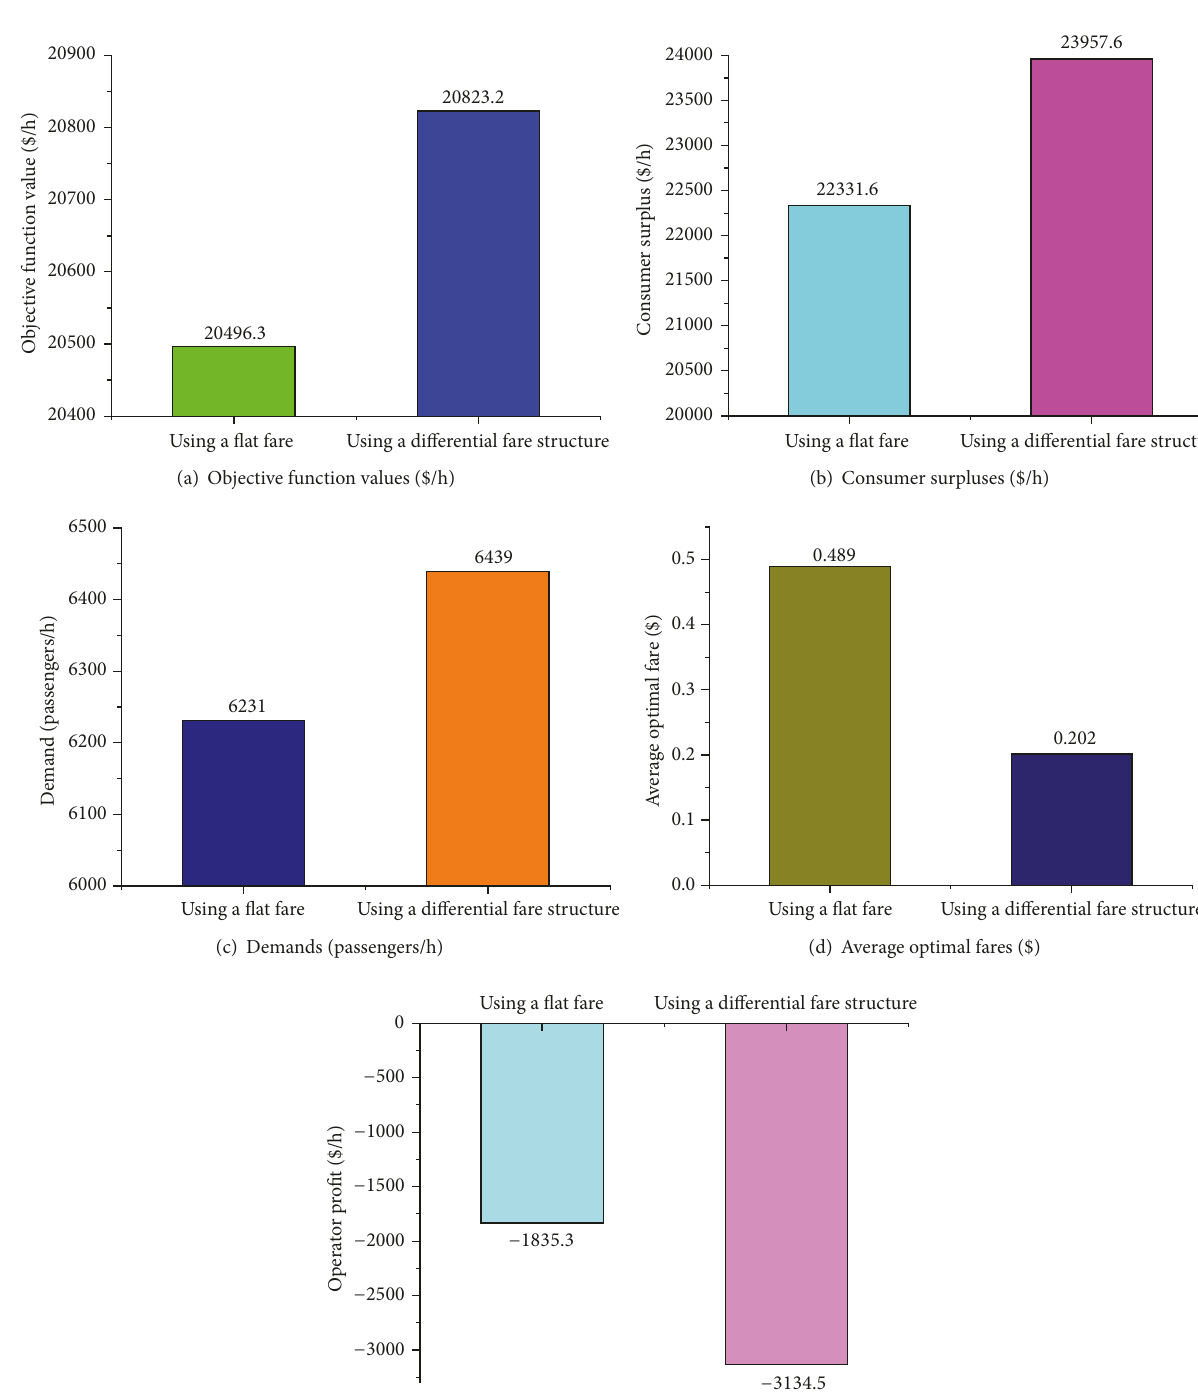
Figure 6: Optimal results of two models using flat and differential fare